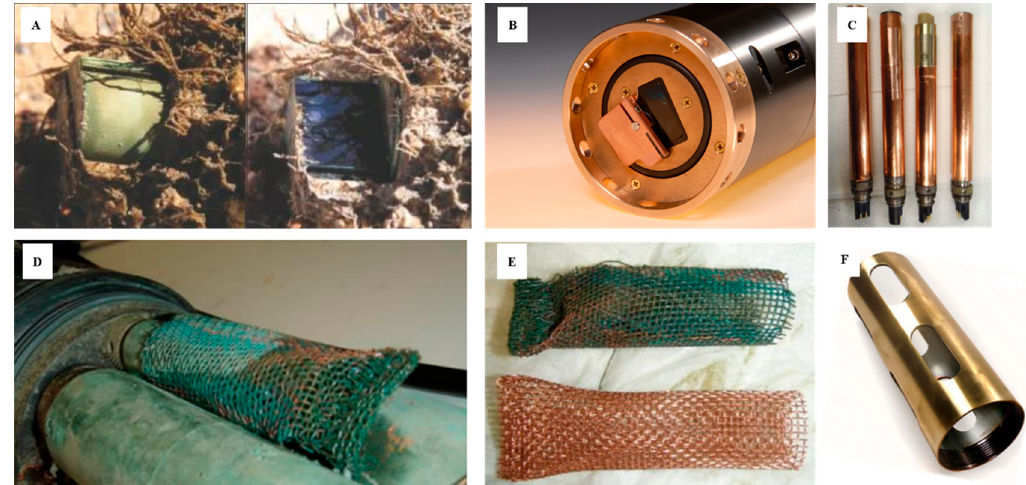
Figure 5. Sensor optics protected against biofouling by copper. ( A ) Copper shutter in the OBS501 Turbidity Probe [57]); ( B ) copper shutter + wiper in Water Quality Monitor (WQM) Wet-Labs and Sea-Bird Scientific sensor [50]; ( C ) sensor covered with copper tape; ( D , E ) antifouling copper “sock” used for conductivity sensors [81]; ( F ) copper guard [82] (reproduced with permission of Sea-Bird Scientific (Bellevue, WA, USA) and the permission of Campbell-Scientific (Loughborough, UK).